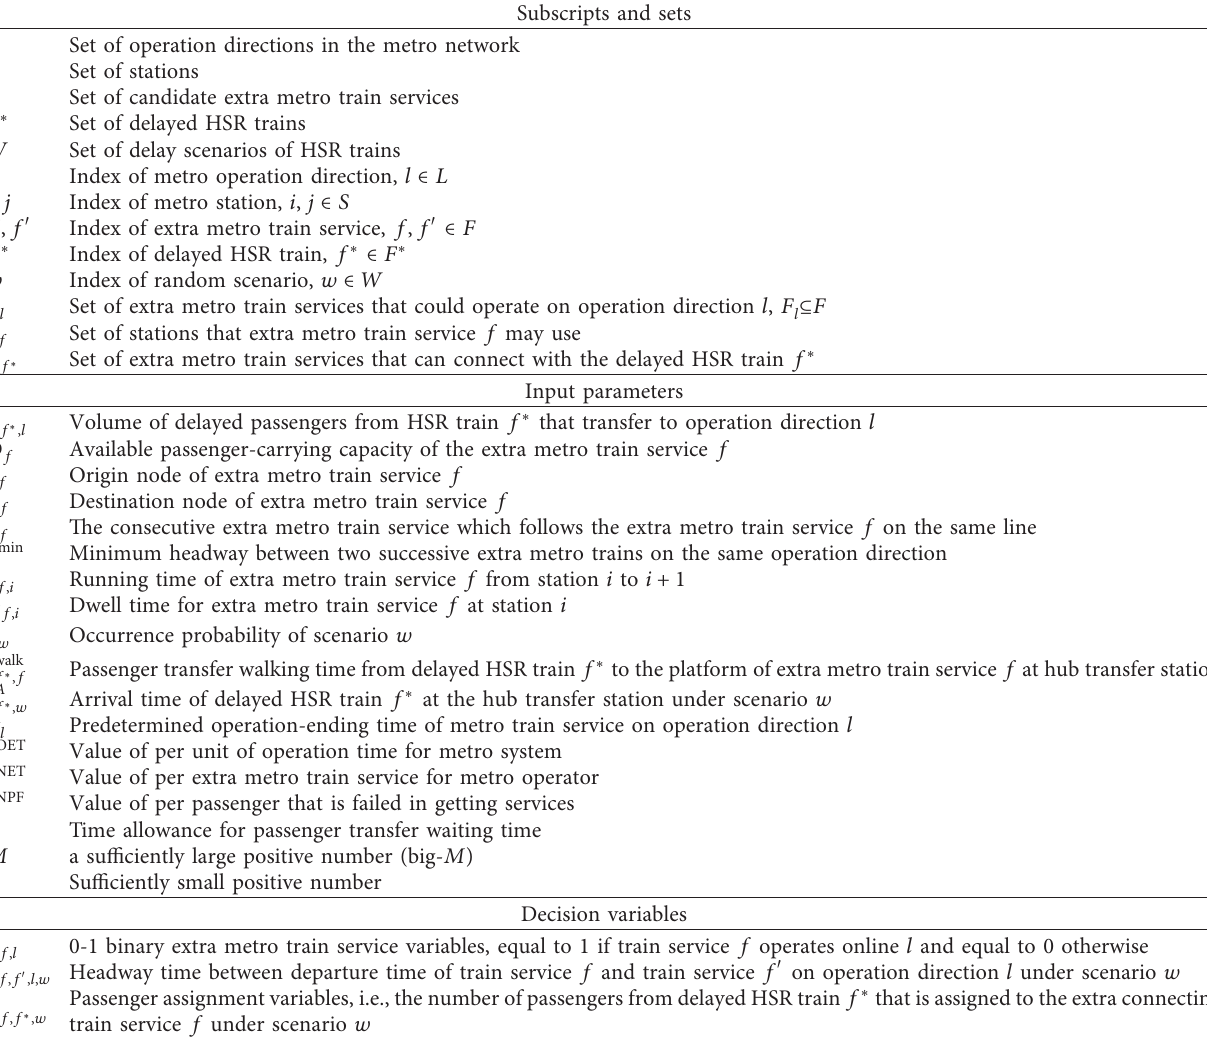
Table 3: Sets, subscripts, input parameters, and decision